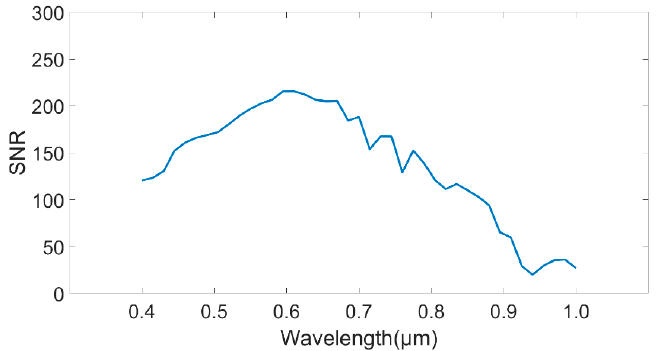
Figure 4. The SNR of the spectrometer in the spectral range of 0.4~1.0 μ m.